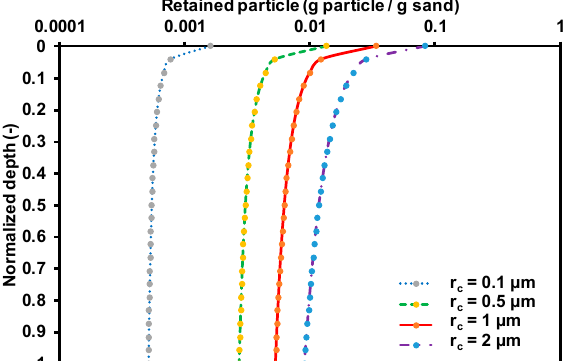
Figure 3. Simulated retention profiles of colloidal particles at in inlet colloidal particle sizes ranging from 0.1 to 2 µm.